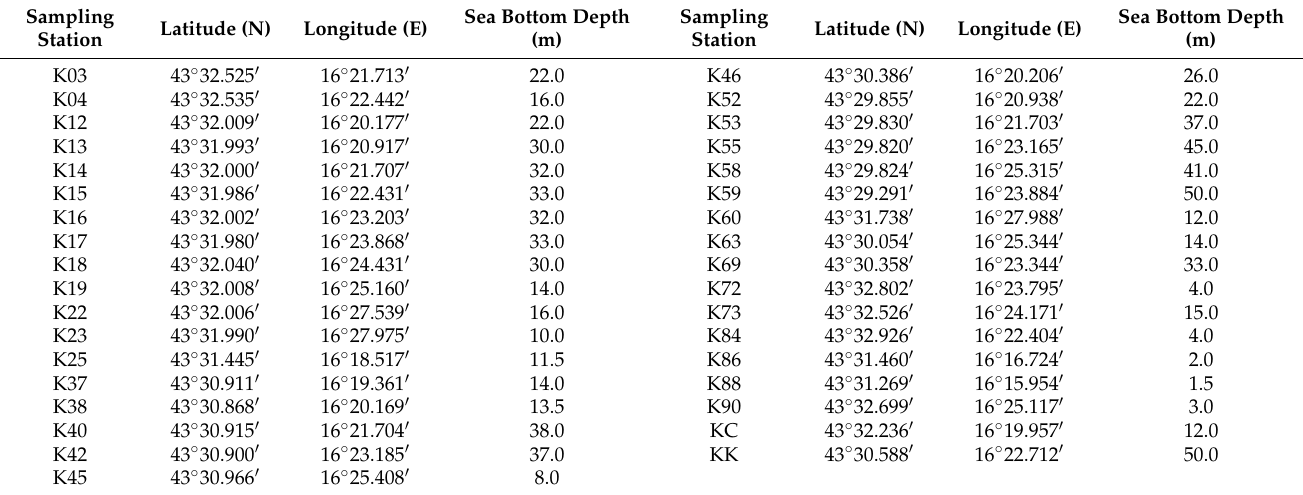
Table 1. Geographical coordinates and sea bottom depths of sampling